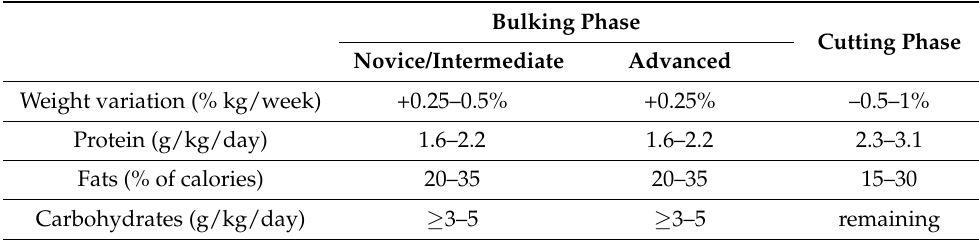
Table 2. Dietary recommendations for bodybuilders in the two main phases of the competitive cycle. Data extracted from Helms et al. [14] and Iraki et al.